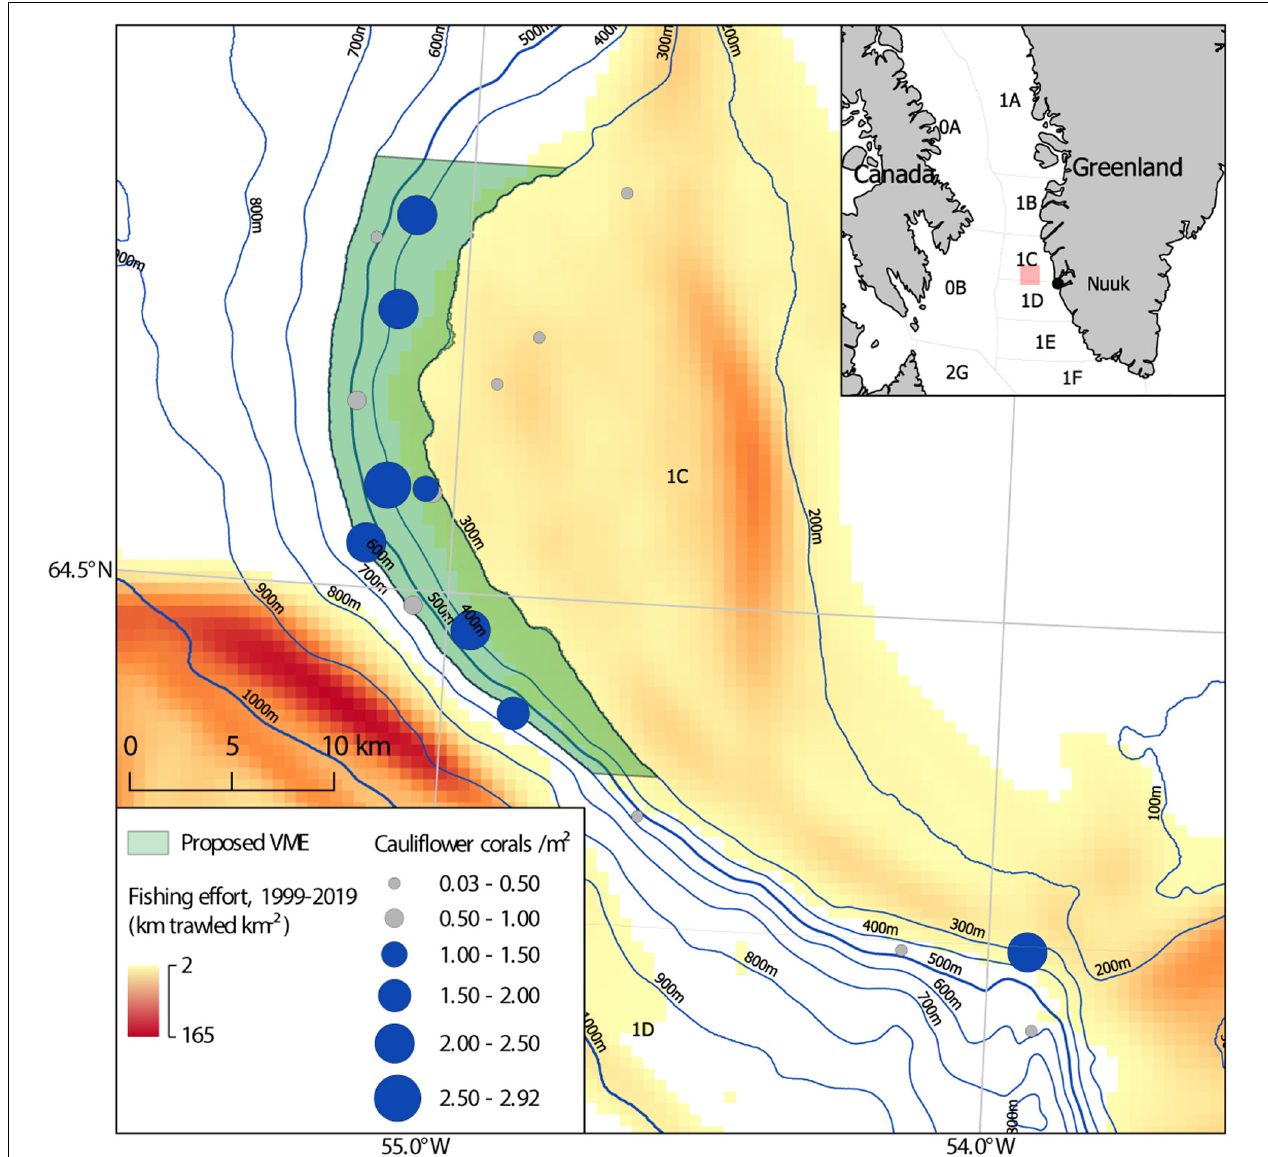
FIGURE 9 | Map of the 486 km 2 proposed soft coral garden vulnerable marine ecosystem (VME) (light green), on the continental slope of the Toqqusaq Bank, west Greenland. NAFO Divisions are indicated. The mean density of cauliflower coral colonies is shown (circles), with those stations exhibiting a density ≥ 1 m 2 highlighted in blue ( < 1 m 2 gray). Fishing effort is based on haul by haul logbook data from 1999 to 2019, used to determine km trawled km − 2